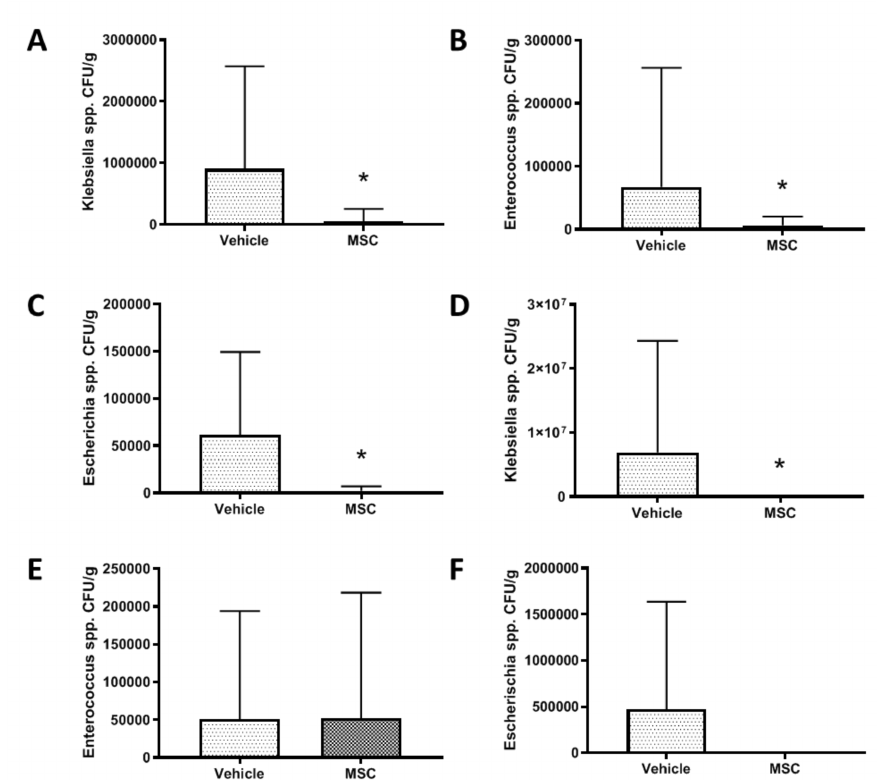
Figure 4. Bacterial CFU reduction after contemporary CD362 + UC-MSC administration in severe systemic sepsis. The colony counts representative of Klebsiella spp. ( A ), Enterococcus spp. ( B ) and Escherichia spp. ( C ) were reduced in liver tissue homogenate at 48 h after CD362 + UC-MSC administration in animals who underwent severe systemic sepsis. This was also observed in spleen homogenate samples ( D – F ). Bars represent mean ( n = 8 / 14), error bars represent SD. * = Statistically significant ( p < 0.05) with respect to